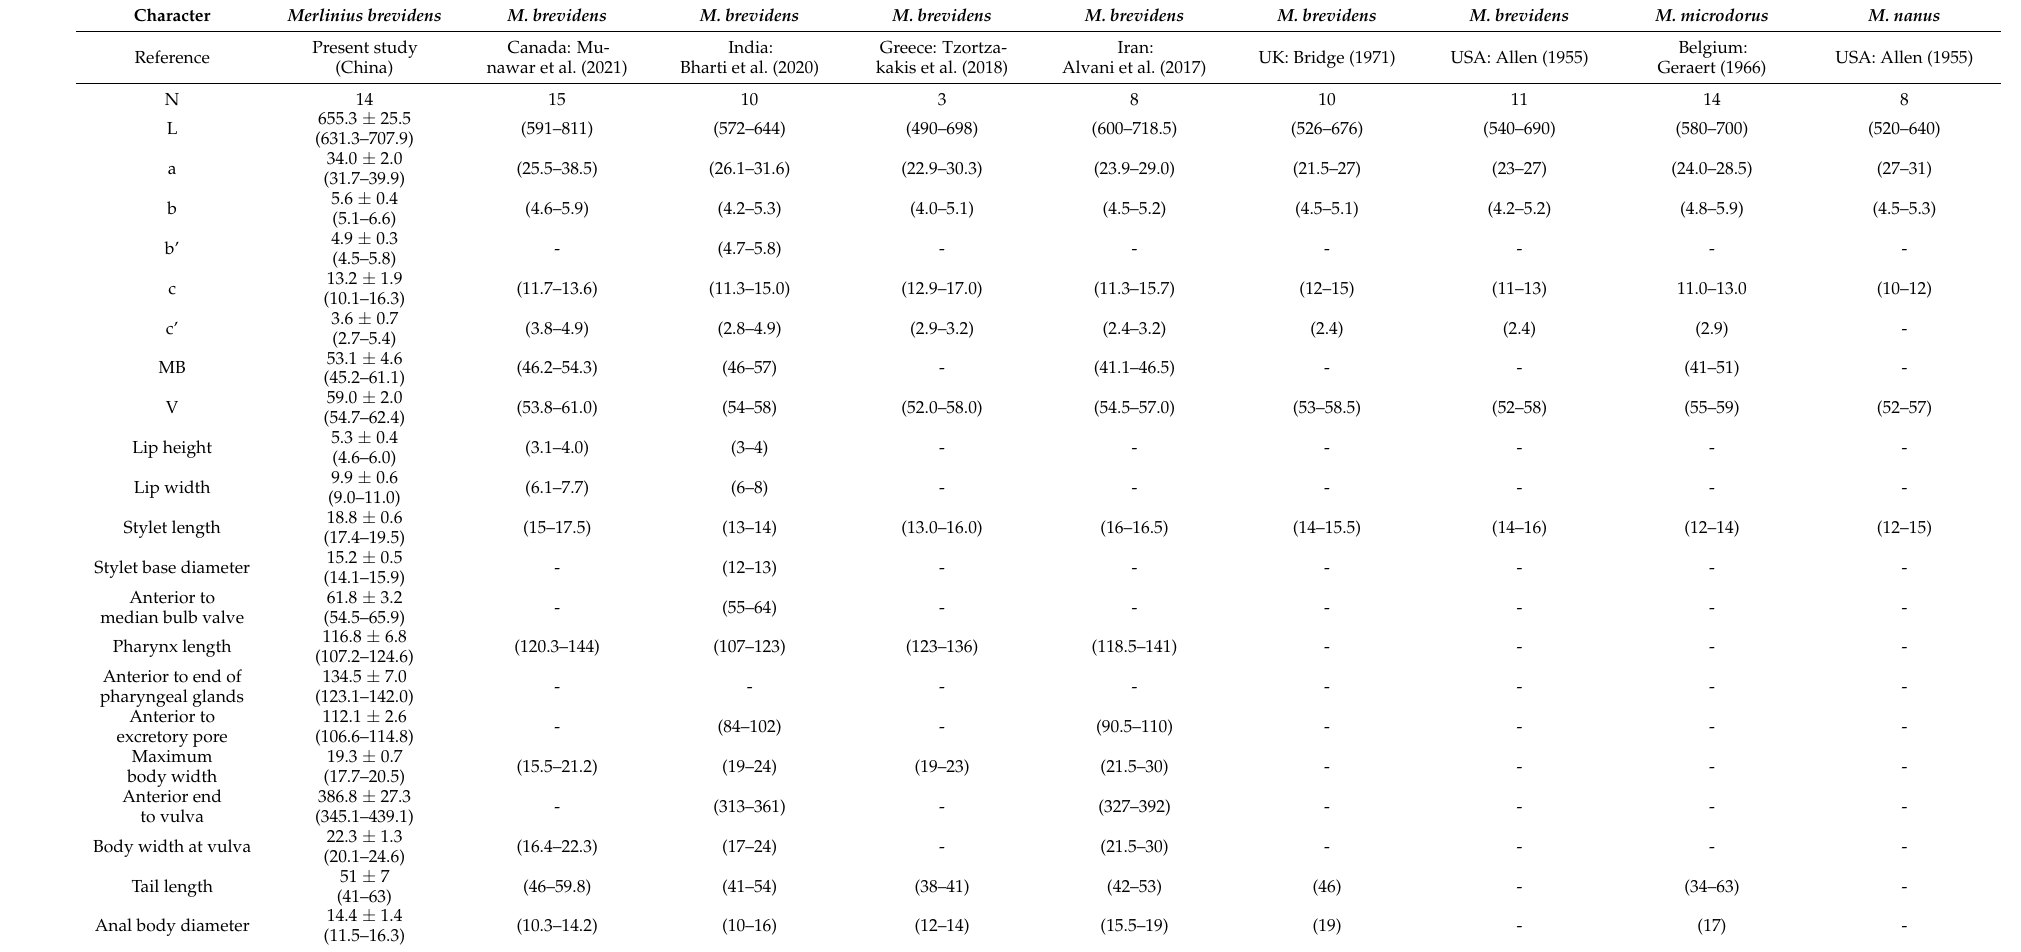
Table 4. Comparative morphometrics of females from populations of Merlinius brevidens . All measurements are in micrometers (except n, ratio, and percentage) and in the form: mean ± standard deviation